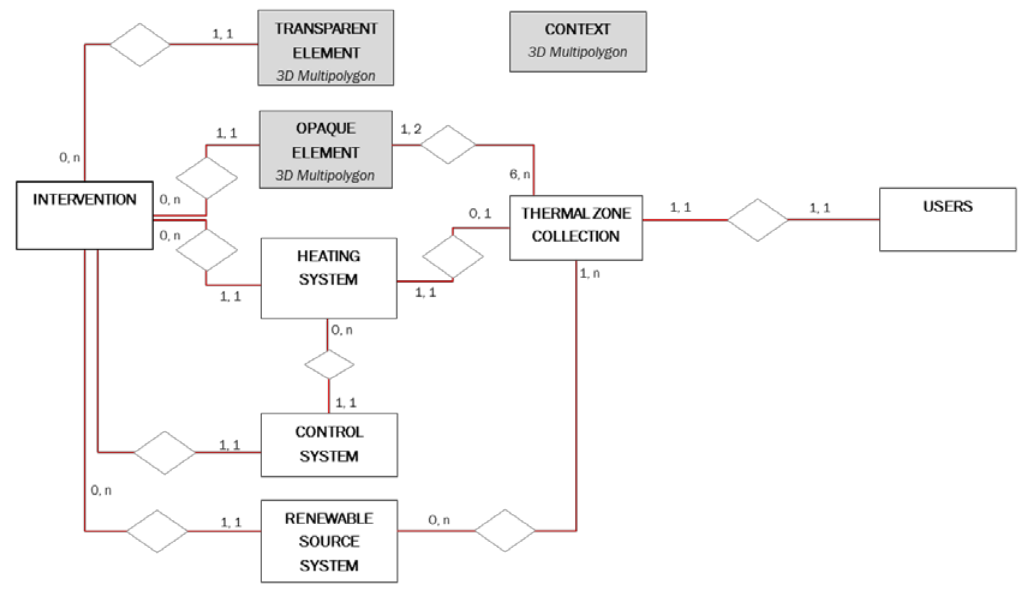
Figure 2: E-R schema for the urban